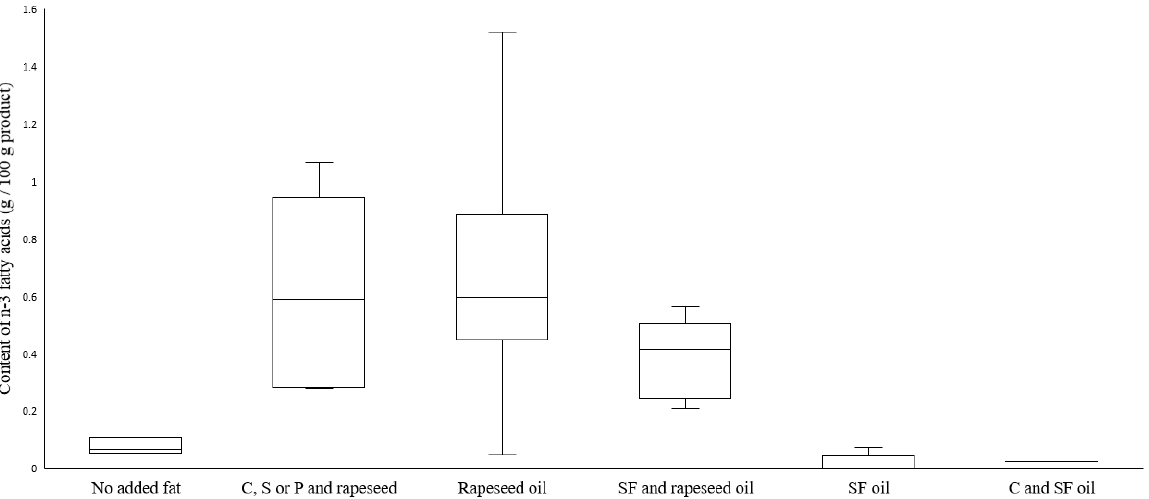
Figure 6. Boxplot of the omega-3 (n-3) fatty acid content, sorted and analyzed in meat substitutes based on added fat, as stated on the package. The only n-3 fatty acid present in the meat substitutes was alpha-linolenic acid (ALA). Abbreviations: C, coconut oil; S, shea butter; P, palm oil; SF, sunflower oil. Line inside the box shows the median value, top of each box is the 75th percentile, and bottom of each box is 25th percentile. Whiskers are maximum and minimum values.